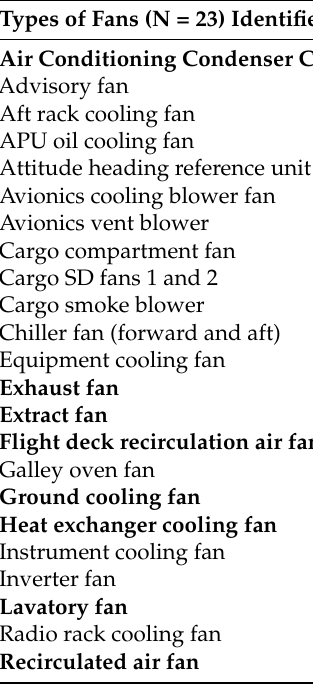
Table 2. Types of fans referenced in fume/smoke